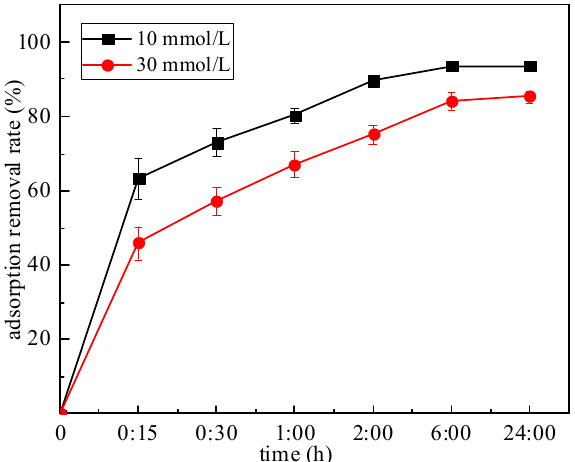
Figure 5. Relationship between adsorption time and removal rate.